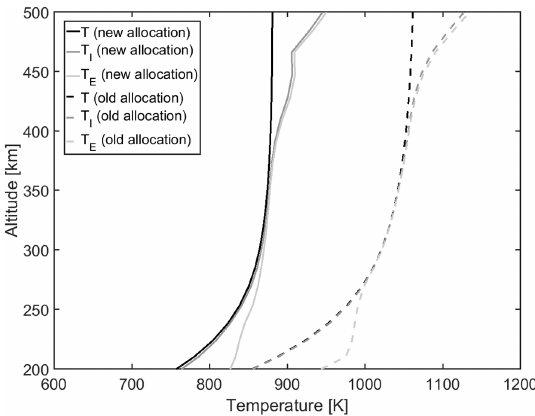
Figure 25. Effect of the new (solid lines) and old (dashed lines) allocation of the exothermic excess energy on the neutral, ion and electron temperature respectively (date: 10 March 2002, 00:00; 0 ◦ latitude and 0 ◦